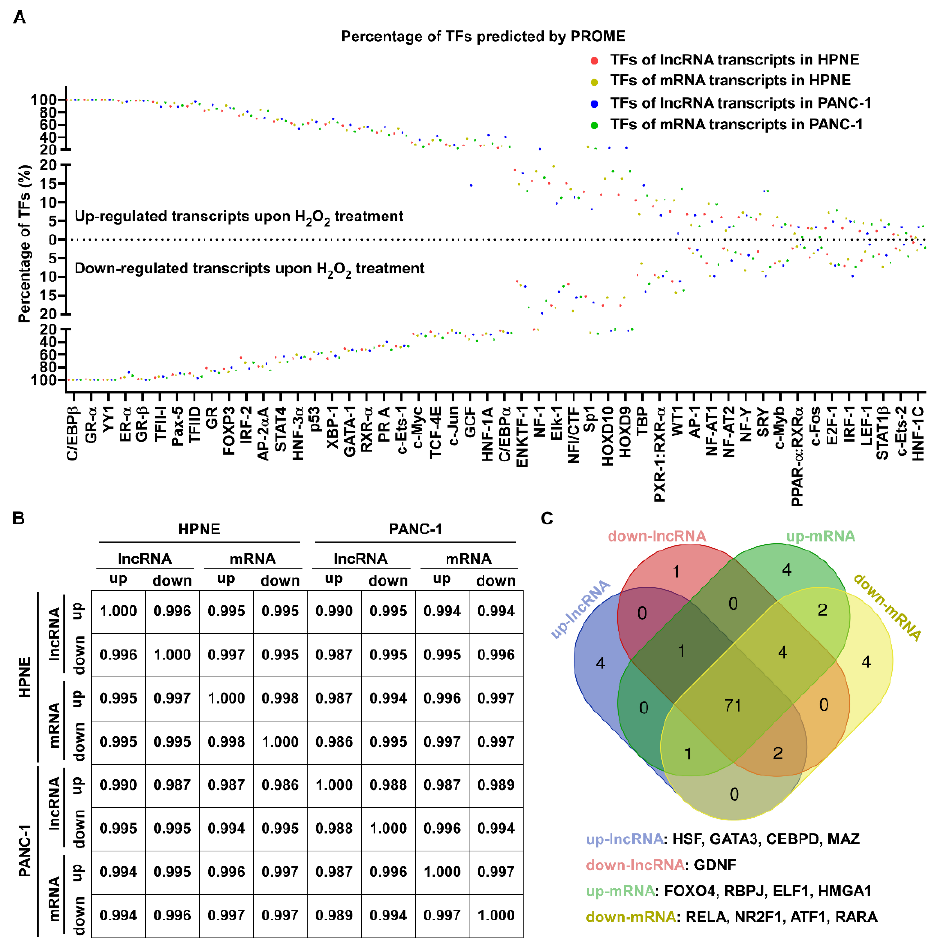
Figure 5. Transcription factors responding to H 2 O 2 stress in HPNE and PANC-1 cells revealed by PROMO analysis. ( A ) Transcription factors of significantly changed lncRNA and mRNA transcripts promoters were predicted by PROMO analysis, and the percentages of transcription factors dis- tributed in promoters of the up- and downregulated lncRNA and mRNA transcripts after H 2 O 2 treatment of HPNE and PANC-1 cells are shown by dot plot. The dots below the dotted line represent the promoters of downregulated transcripts, while the top dots represent the promoters of upregu- lated transcripts. ( B ) The correlation of transcription factors between the up- and downregulated lncRNA and mRNA transcripts after H 2 O 2 treatment in HPNE and PANC-1 cells. ( C ) Venn diagram showing the transcription factors not shown in Figure 4A. The transcription factors observed only in one type of transcriptional change are shown under the Venn